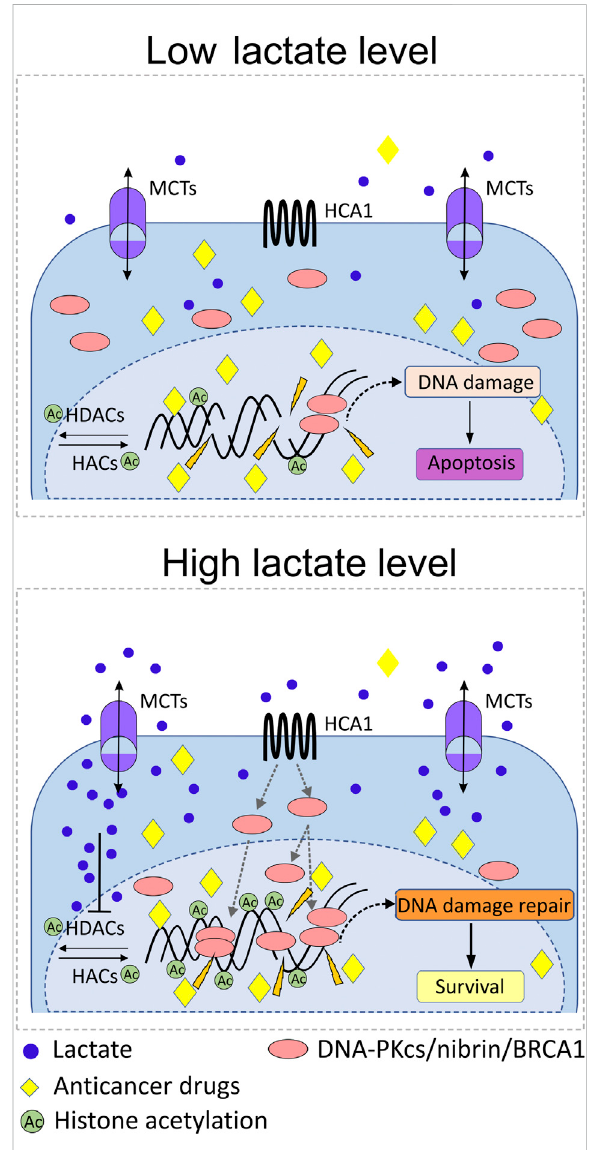
Role of lactate in the mobilization of DNA repair proteins and protection against anticancer radiotherapy or drug-based therapies. Abundance of lactate in pericellular and intracellular compartments as a result of MCT1/4-driven fl ux of lactate triggers upregulation of particular DNA repair proteins of NHEJ and HR systems in the nucleus, for example, DNA-PKcs, BRCA1, and nibrin. Promotion of HCA1 signaling by lactate, and acetylation of chromatin due to lactate inhibitory activity against histone deacetylases (HDACs) induce transcription of DNA repair genes and recruitment of DNA-PKcs, BRCA1, and nibrin to nuclear compartment. The lactate-rich environment accelerates processing of genomic DNA damaged by anticancer drugs/radiation and thus promotes the survival of cancer cells. Upregulation of cellular DNA repair capacity is one of the most important cellular mechanisms that account for ineffective cervical anticancer radiotherapy and drug-based